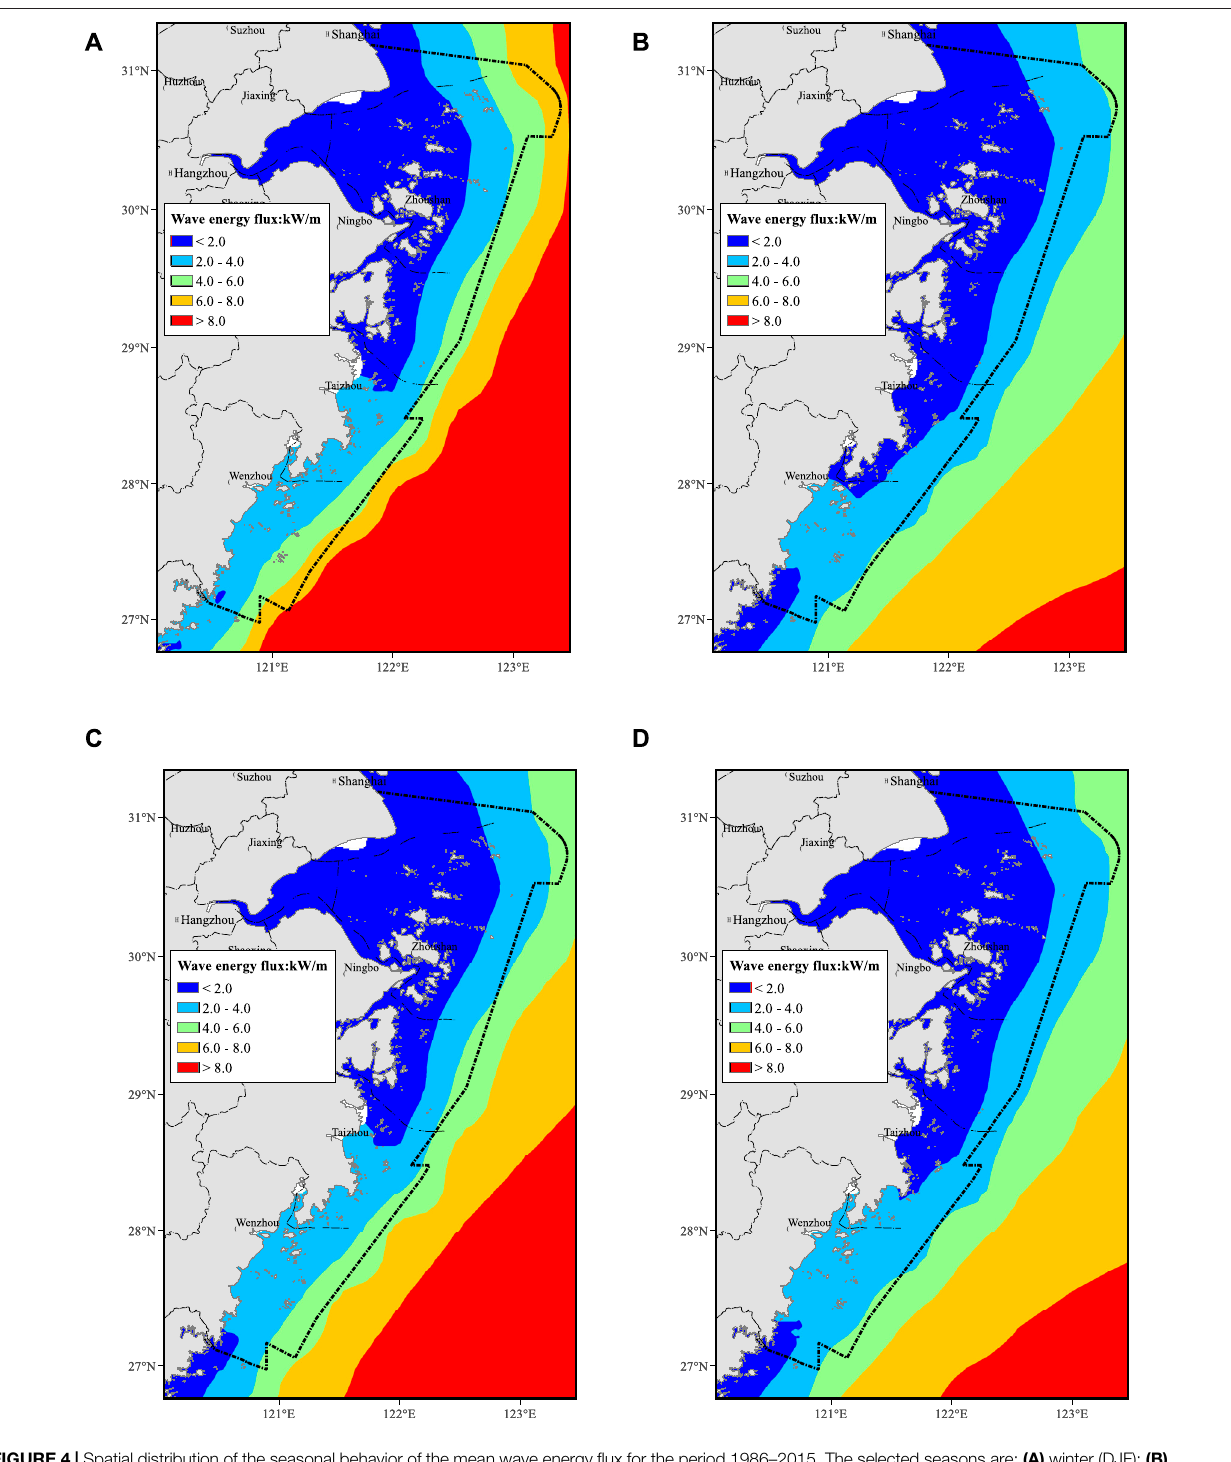
FIGURE 4 | Spatial distribution of the seasonal behavior of the mean wave energy fl ux for the period 1986 – 2015. The selected seasons are: (A) winter (DJF); (B) spring (MAM); (C) summer (JJA); and (D) autumn (SON).